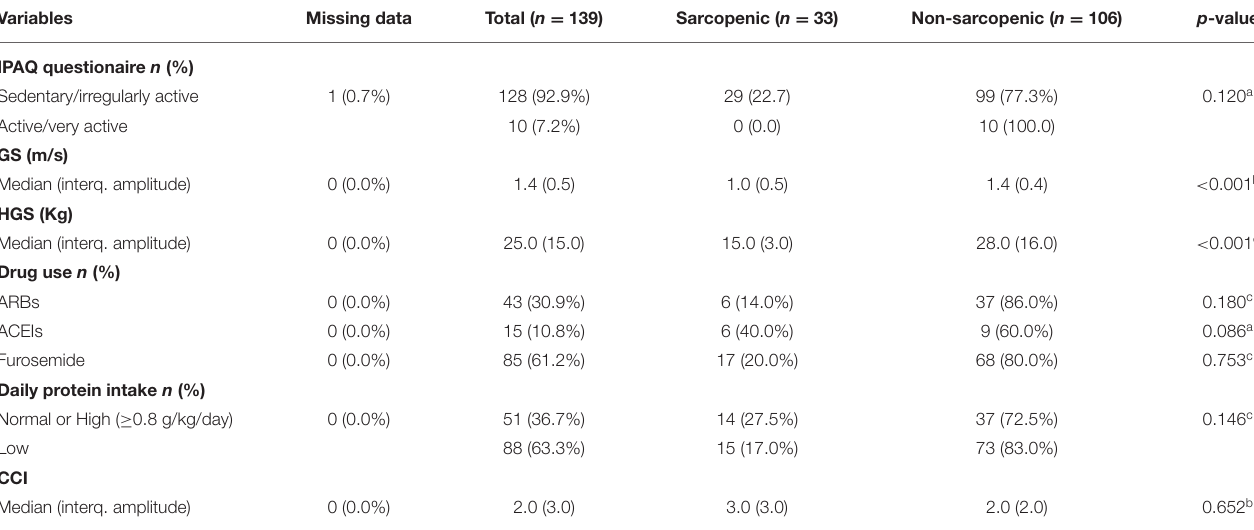
TABLE 3 | Distribution of sarcopenia according to physical activity level, physical performance tests, drug use, daily protein intake and Charlson comorbidity index in the CKD study population. Variables Missing data Sarcopenic ( n = 33) Non-sarcopenic ( n = 106)